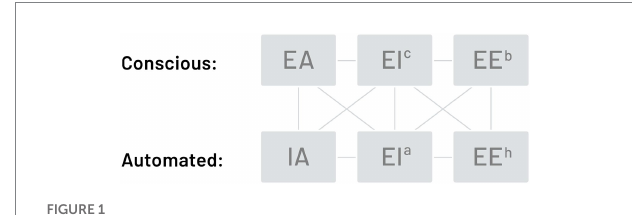
FIGURE 1 An attitude-based dual-processing framework of